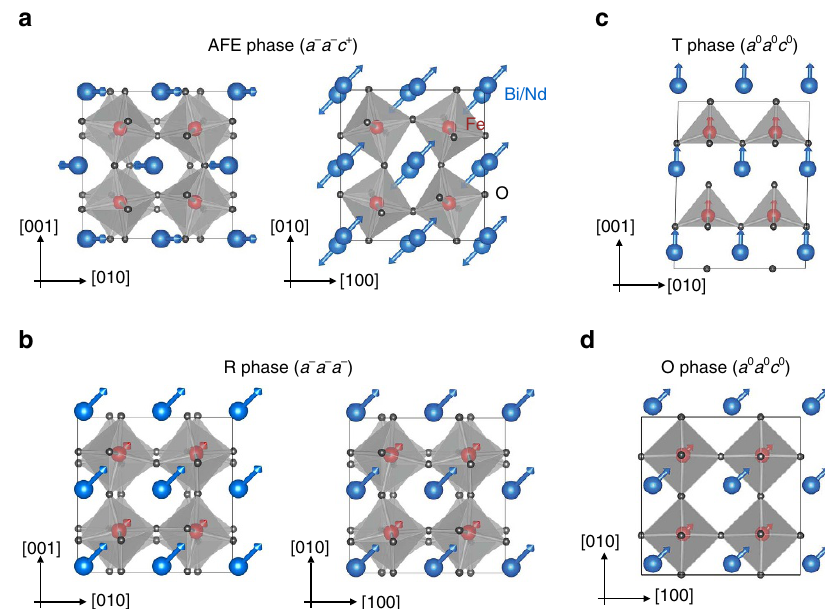
Figure 2 | Relevant structures of Bi 1 (cid:2) x Nd x FeO 3 . ( a ) The antiferroelectric orthorhombic Pnma phase (AFE phase), characterized by the anti-polar distortions along the pseudo-cubic [110] direction, and oxygen octahedral tiltings ( a (cid:2) a (cid:2) c þ in Glazer notations 14 ). ( b ) The ferroelectric R3c phase (R phase), characterized by polar distortions and anti-phase tiltings about the [111] direction ( a (cid:2) a (cid:2) a (cid:2) ). ( c ) The ferroelectric tetragonal P4mm phase (T phase), characterized by polar distortions along the [001] direction and no tiltings ( a 0 a 0 c 0 ). ( d ) The ferroelectric Amm2 orthorhombic phase (O phase), characterized by polar distortions along the [110] direction and no tiltings ( a 0 a 0 c 0 ). The VESTA code is used for the visualization 43 . Arrows represent local electric dipoles.